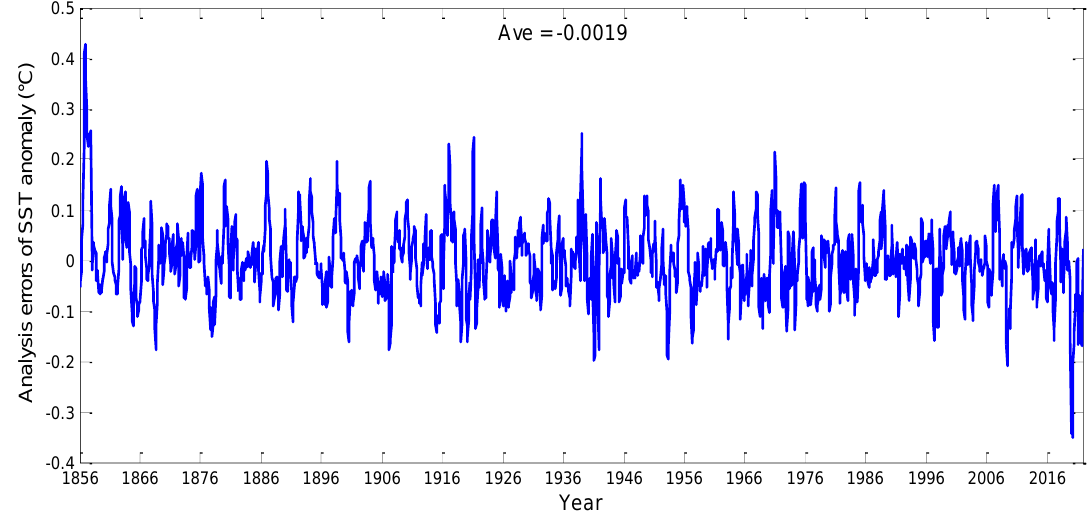
Figure 2. Time-varying analysis errors of SST anomalies in EAKF-Assim.